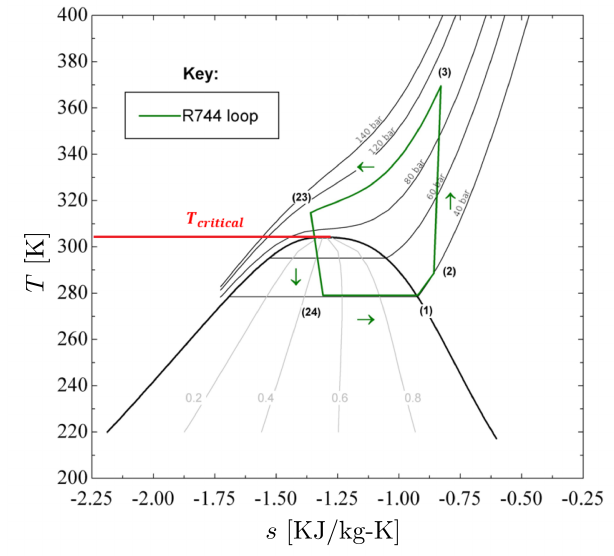
Figure 2. Transcritical heat pump refrigerant loop on a T - s